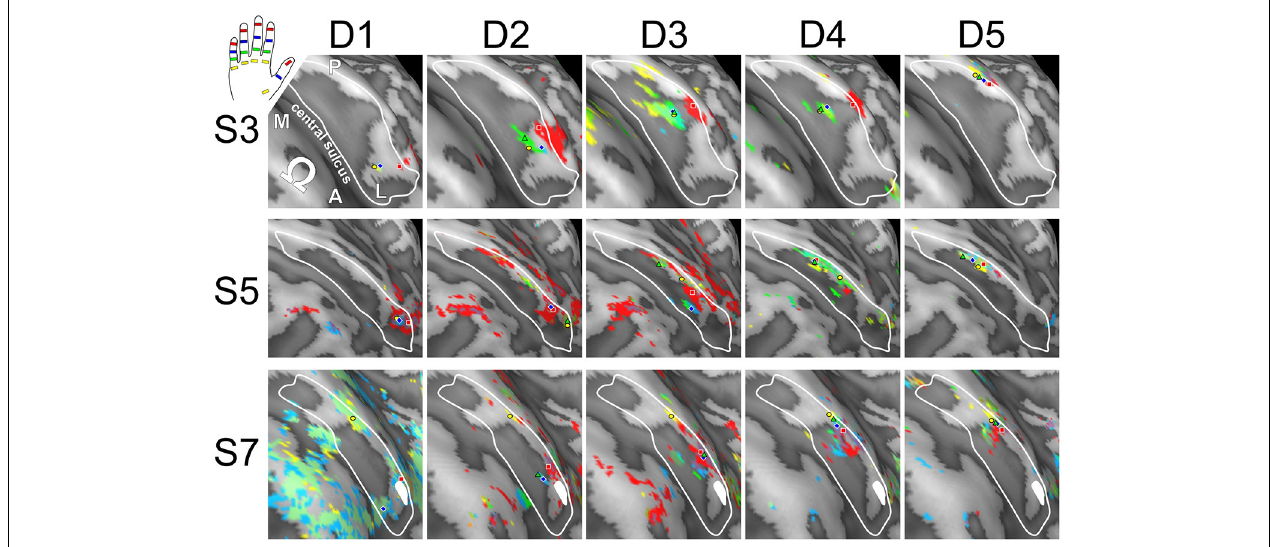
FIGURE 5 | Intra-digit representations of phalanges and bases (subjects S3, S5, and S7). View from above onto the inflated surface reconstruction of the left hemisphere with the motor hand knob ( (cid:2) ) in the foreground and the somatosensory BA 3b hand area in the center (convex areas, light gray; concave areas, dark gray; putative vessels,